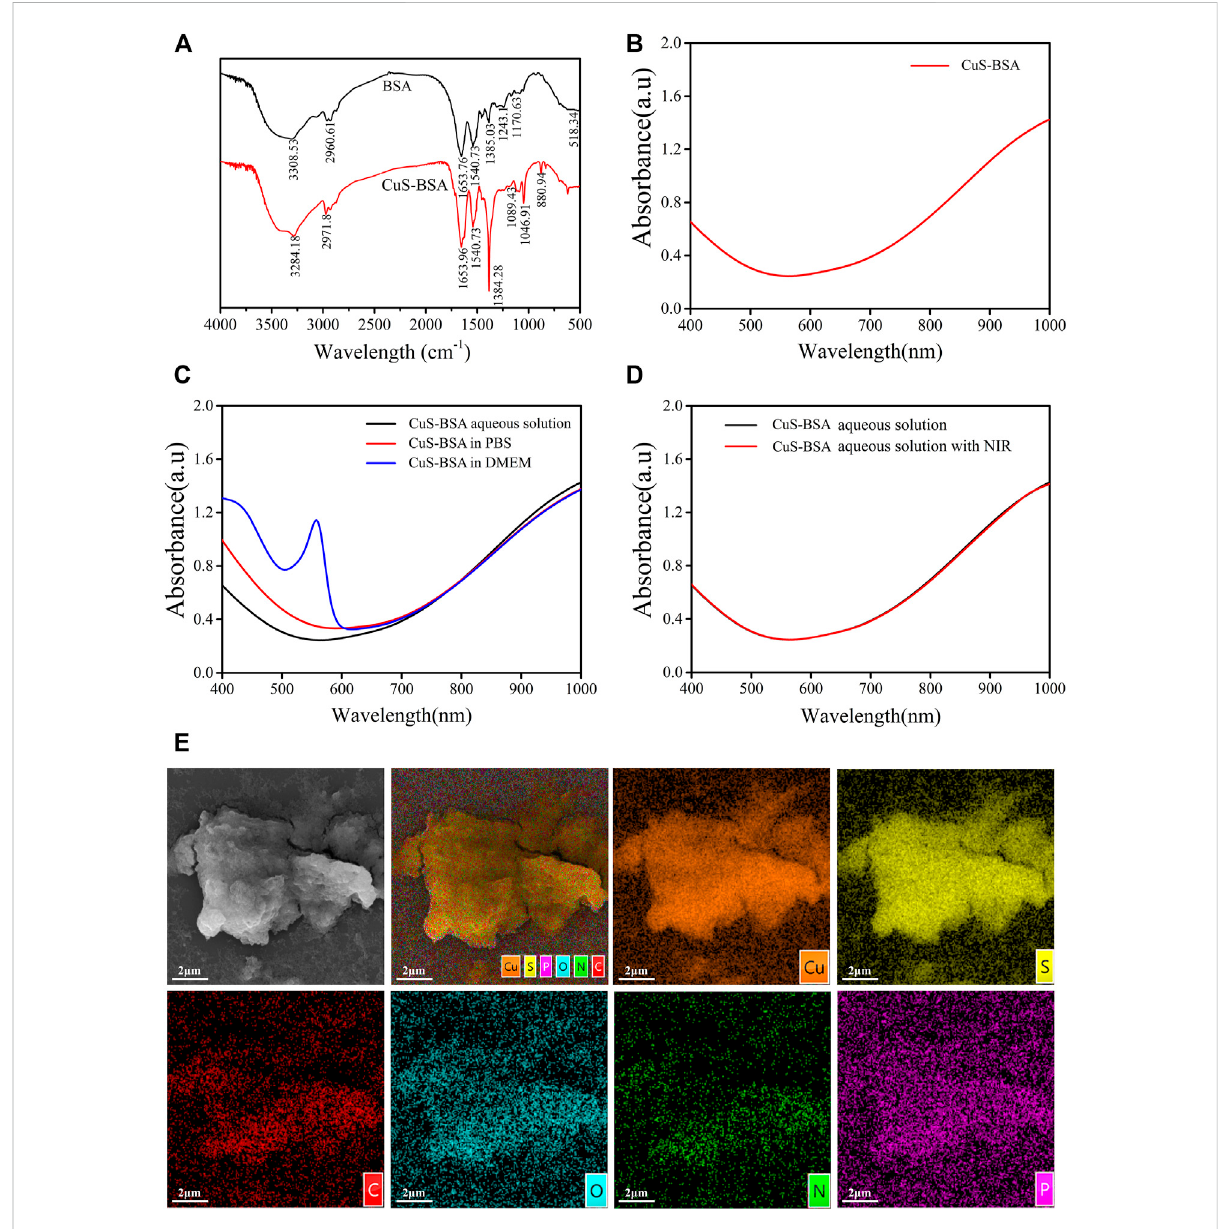
FIGURE 2 FT-IRandUVabsorptionspectra ofCuS-BSA NPs. (A) The FT-IRspectra ofBSAandCuS-BSANPs. (B) UVabsorptionspectra ofCuS-BSA NPsin ultrapure water. (C) UV absorption spectra of CuS-BSA NPs in three different solvents: ultrapure water, PBS, and DMEM medium. (D) UV absorption spectra of CuS-BSA NPs in PBS before and after irradiation with 980 nm near-infrared light. (E) SEM morphology image and element mapping analysis of CuS-BSA